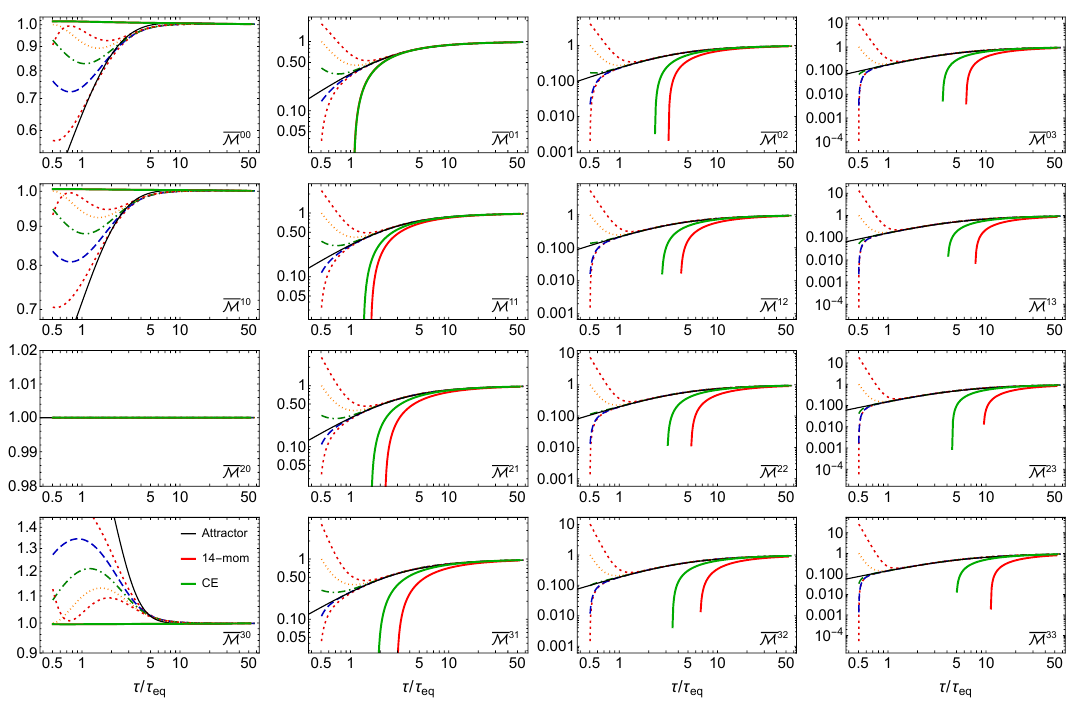
Figure 2 . Scaled moments M nl as a function of rescaled time for the case m = 0 . 2 GeV. The non-solid lines are specific initial conditions initialized at τ 0 = 0 . 1 fm/c with T 0 = 1 GeV and √ α 0 = 1 / 1 + ξ 0 ∈ { 0 . 12 , 0 . 25 , 0 . 5 , 1 , 2 } . The solid black lines correspond to the attractor solution, the solid red lines are the first-order 14-moment predictions in eq. (3.15), and the solid green lines are the first-order Chapman-Enskog predictions in eq.